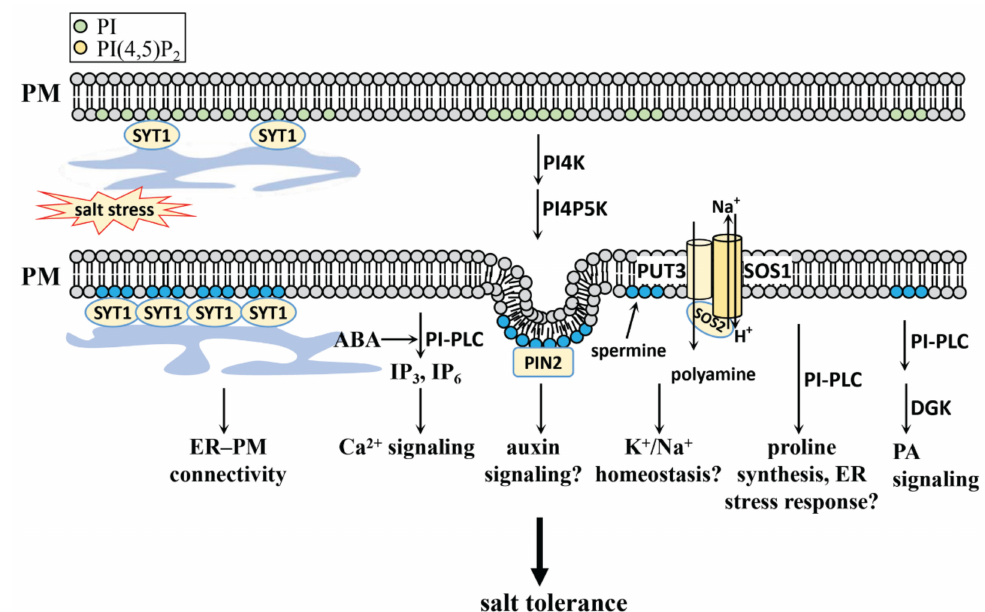
Figure 3. The regulatory role of PI(4,5)P 2 in the salt stress response of plants. PI(4,5)P 2 level is induced by salt stress. PI(4,5)P 2 at the plasma membrane interacts with SYT1 and mediates the salt stress-induced ER and plasma membrane connectivity. The membrane trafficking regulation of PIN2 by PI(4,5)P 2 may participate in salt stress response through the regulation of auxin signaling. PUT3, a polyamine uptake transporter, interacts with SOS1 and SOS2 under salt stress condition, and the application of spermine can induce PI(4,5)P 2 accumulation, which indicate a possible link between polyamine, PI(4,5)P 2 and Na + extrusion under salt stress condition. The hydrolysis of PI(4,5)P 2 by PI-PLC can produce inositol phosphates, which is involved in Ca 2+ stimulation under salt stress condition, and ABA may participate in this process by the regulation of PLC activity. PI-PLC may also participate in salt stress response by the regulation of proline synthesis and ER stress response, and the further catalysis by DGK can improve plant salt tolerance through PA signaling. PI, phosphatidylinositol; PI(4,5)P 2 , PI 4,5-bisphosphate; PM, plasma membrane; SYT1, synaptotagmin 1; PM, plasma membrane; ER, endoplasmic reticulum; ABA, abscisic acid; PI-PLC, phosphatidylinositol-phospholipase C; PIN2, PIN-FORMED 2; DGK, diacylglycerol kinase; PUT3: polyamine uptake transporter 3; SOS, salt overly